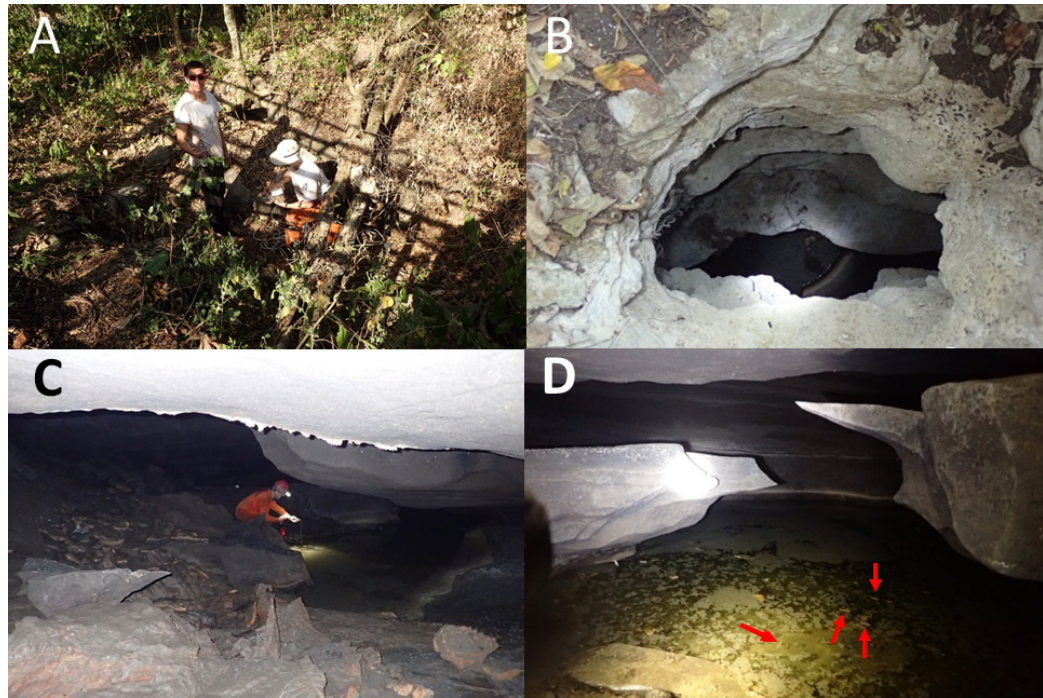
Figure 3. Sótano del Toro #2. ( A ); Entrance pit. ( B ); Narrow portion of the entrance pit. ( C ); Typical galleries within the cave. ( D ); Entrance lake. Arrows point to fish.